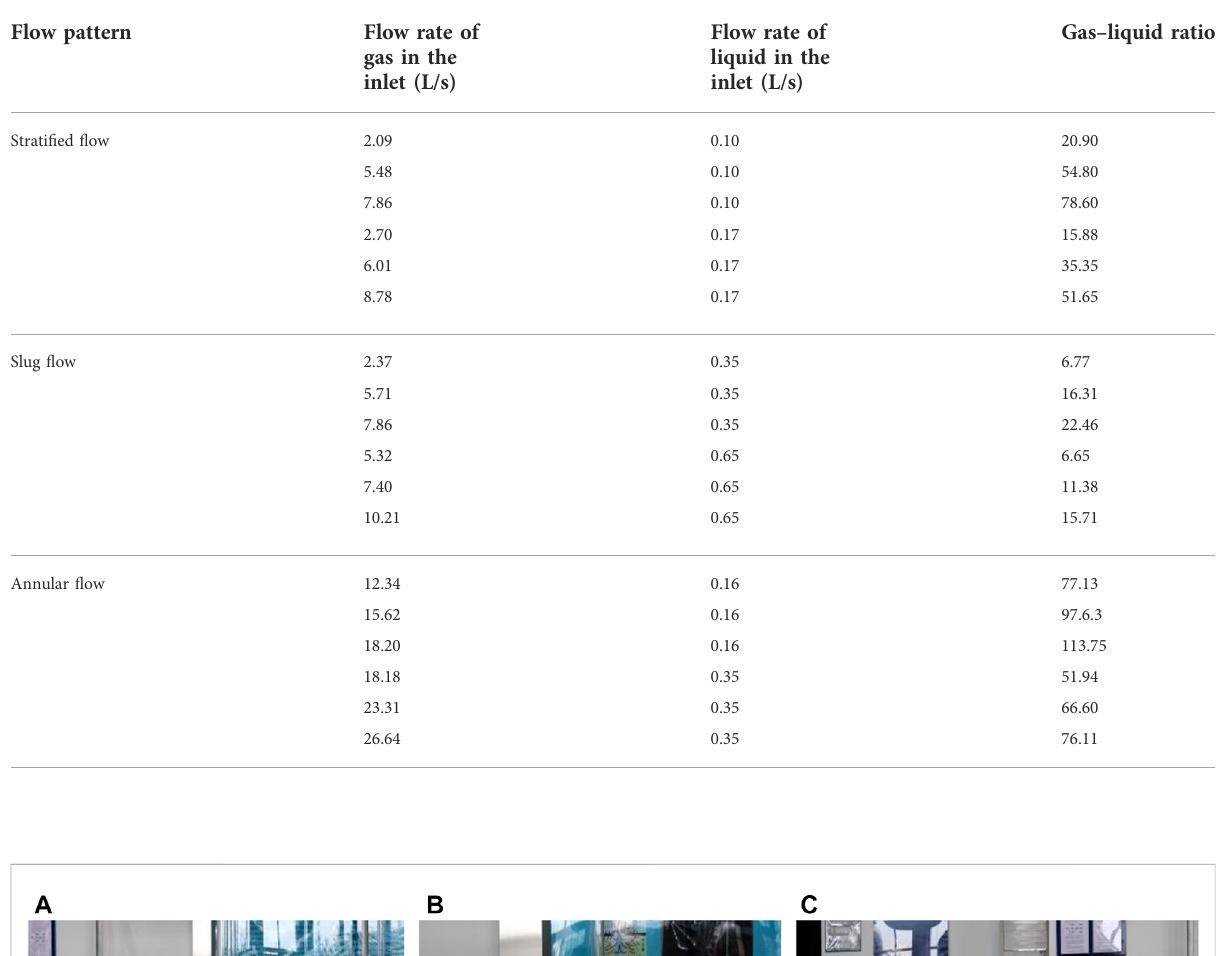
TABLE 2 Flow rate of gas and liquid in the inlet under different fl ow pattern conditions.